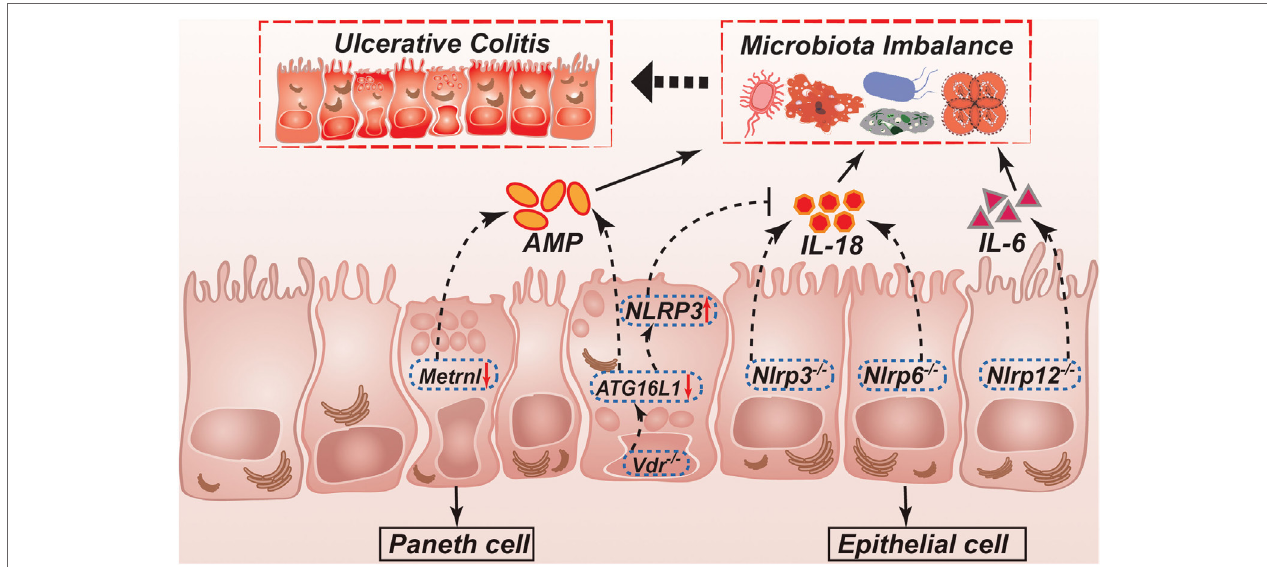
FigURe 2 | Possible mechanisms controlled by NLRPs, VDR, and Metrnl in regulation of intestinal homeostasis and ulcerative colitis. NLRP3 and NLRP6 inflammasomes regulate secretion of IL-1 β and IL-18. IL-18 helps to maintain a non-pathogenic gut microflora, which promote a healthy gut environment. IL-18 is not produced in Nlrp3 − / − or Nlrp6 − / − mice, leading to the development of potentially pathogenic species. Nlrp12 − / − mice results in a more inflammatory environment caused by higher production of cytokines such as IL-1 β and IL-6. ATG16L1 is decreased in Vdr − / − mice, which leading to reduction of AMP. Furthermore, ATG16L1 decreasing can also inhibit IL-18 production through upregulating NLRP3 expression. In the intestinal epithelial cell-specific Metrnl knockout mice, reduction of AMP leading to microbiota imbalance. NLRP, NLR family, pyrin domain-containing; VDR, vitamin D receptor; AMP, antimicrobial